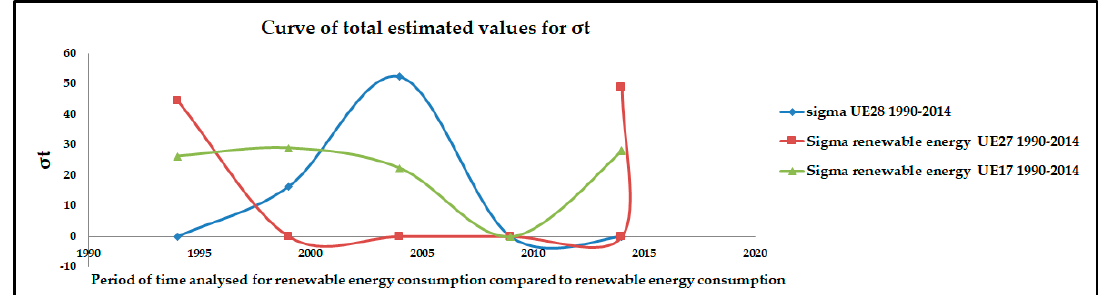
Figure 8. Graphical representation of total values obtained for σ t energy consumption vs. renewable energy consumption.